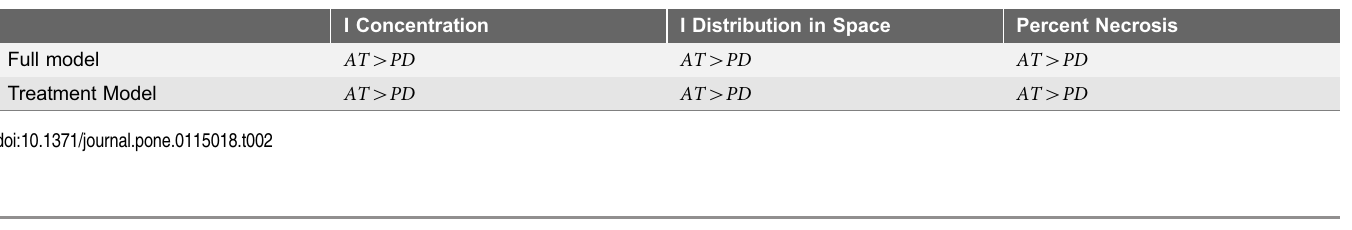
Table 2. Summary of Tumor Response under AT only verses PD only in the Full and Treatments